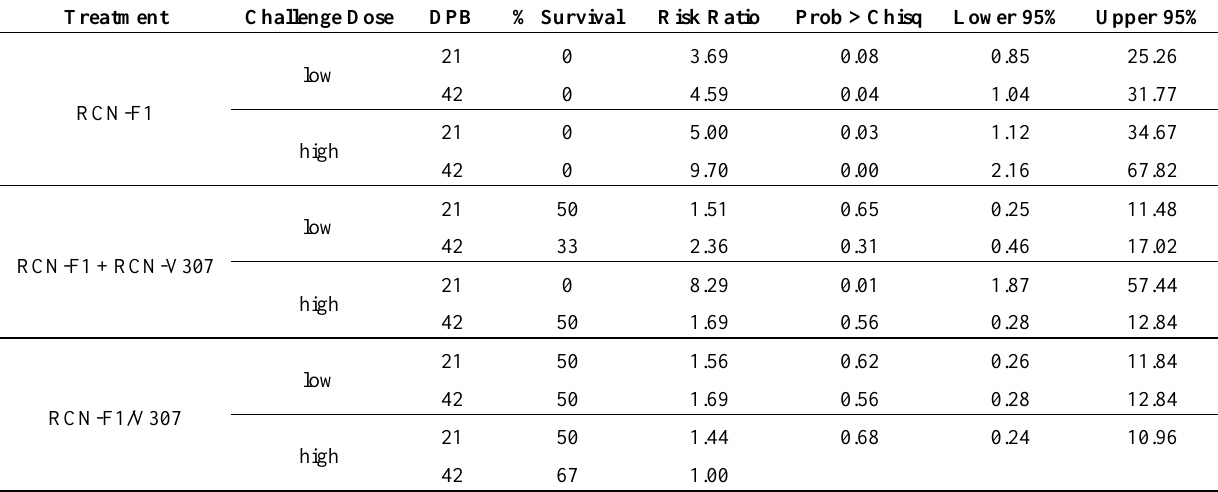
Table 3. Vaccine treatments administered to A/J mice via intramuscular inoculation and their response to challenge with two dosages (low—1.4 × 10 4 mouse LD 50 s and high—1.4 × 10 5 mouse LD 50 s) of an F1 negative strain of Yersinia pestis (Java 9, YERS022) at 21 and 42 days post booster vaccination (dpb). Risk ratios are calculated in relation to RCN F1/V307 at the high dose and 42 days dpb.